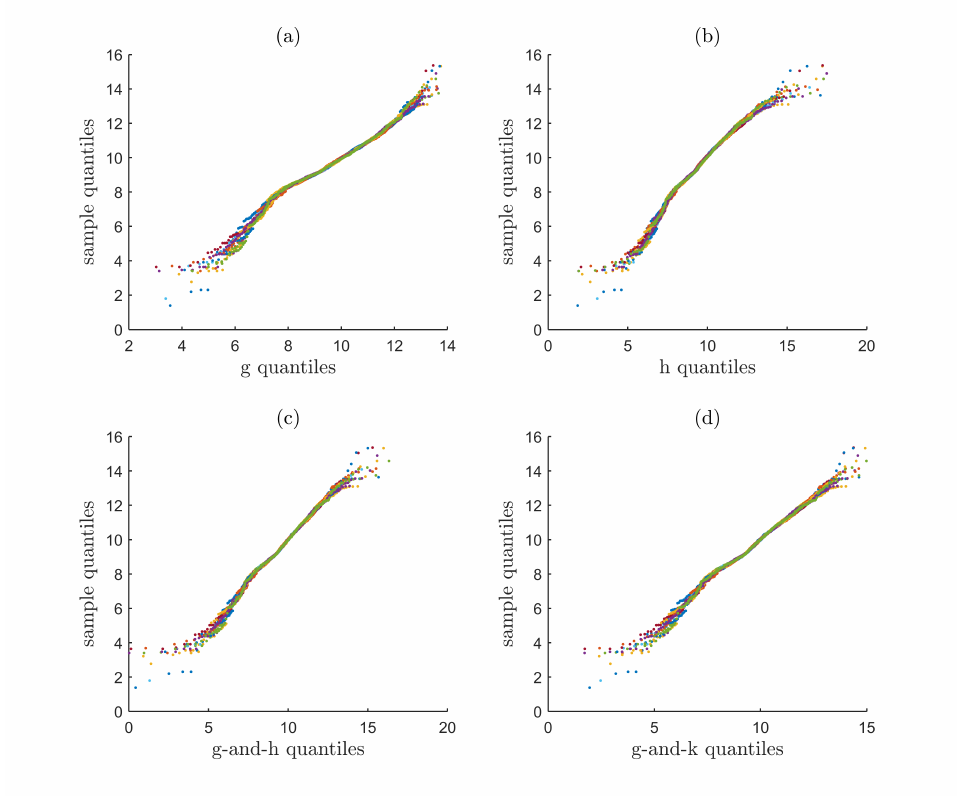
Figure 1. Q-Q plots of monthly partitioned log payments for 1998, where the sample quantiles are plotted against the model quantiles. The panels ( a ), ( b ), ( c ), and ( d ) correspond to the g, h, g-and-h, and g-and-k models,